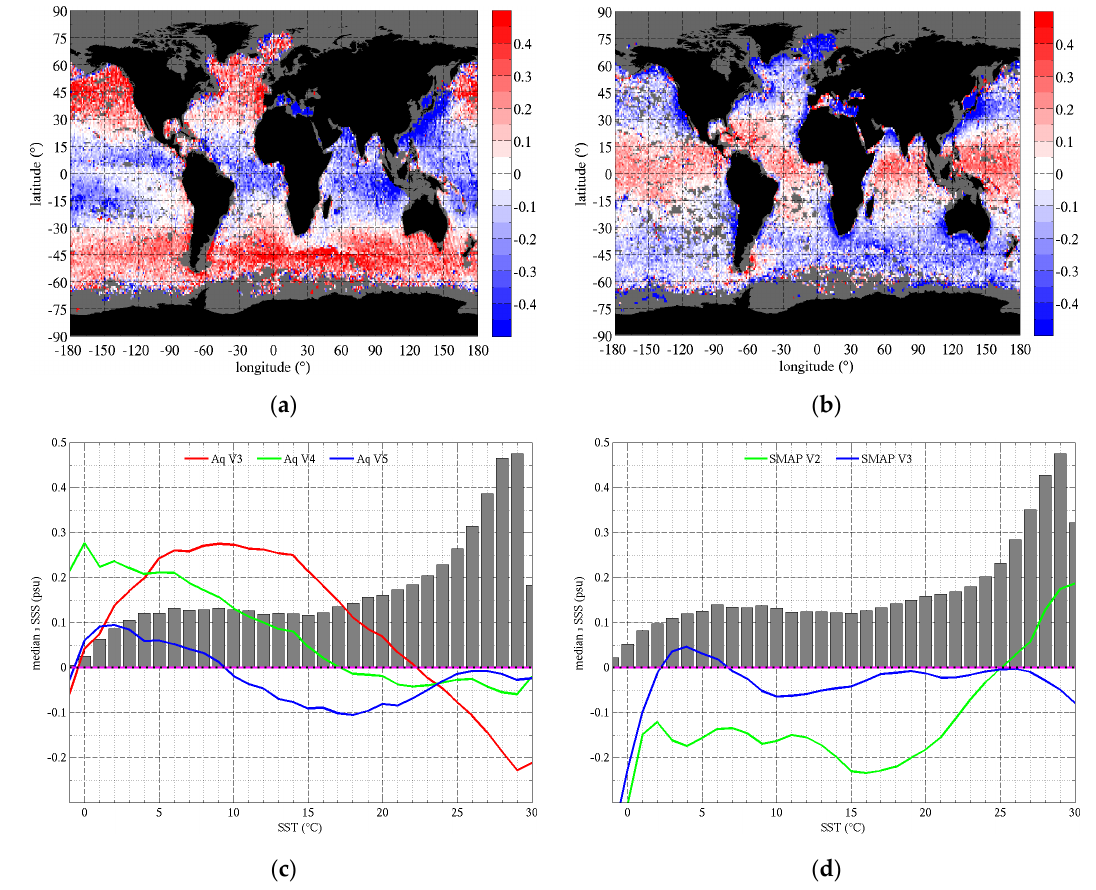
Figure 14. SST dependence of SSS bias for various versions of SMAP and Aquarius products. Top row ( a , b ) reports maps of SSS difference between satellite and in situ for ( a ) Aquarius V3 and ( b ) SMAP V2 averaged over several years from monthly products. The bottom row ( c , d ) reports the SSS difference between satellite and in situ SSS as a function of SST for ( c ) Aquarius V3 (red), V4 (green) and V5 (blue) and ( d ) SMAP V2 (green) and V3 (blue). The vertical bars in the background report the statistical distribution of the samples as a function of SST (amplitude is normalized to the amplitude of SSS curves).